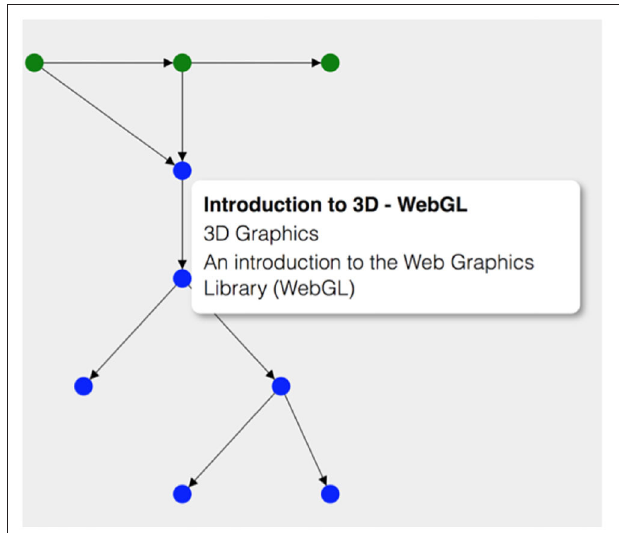
FIGURE 2 | The challenge “tree” used in the second 1-week technology probe that was the fore-runner for the CCCs platform. Mandatory challenges are in green, optional in